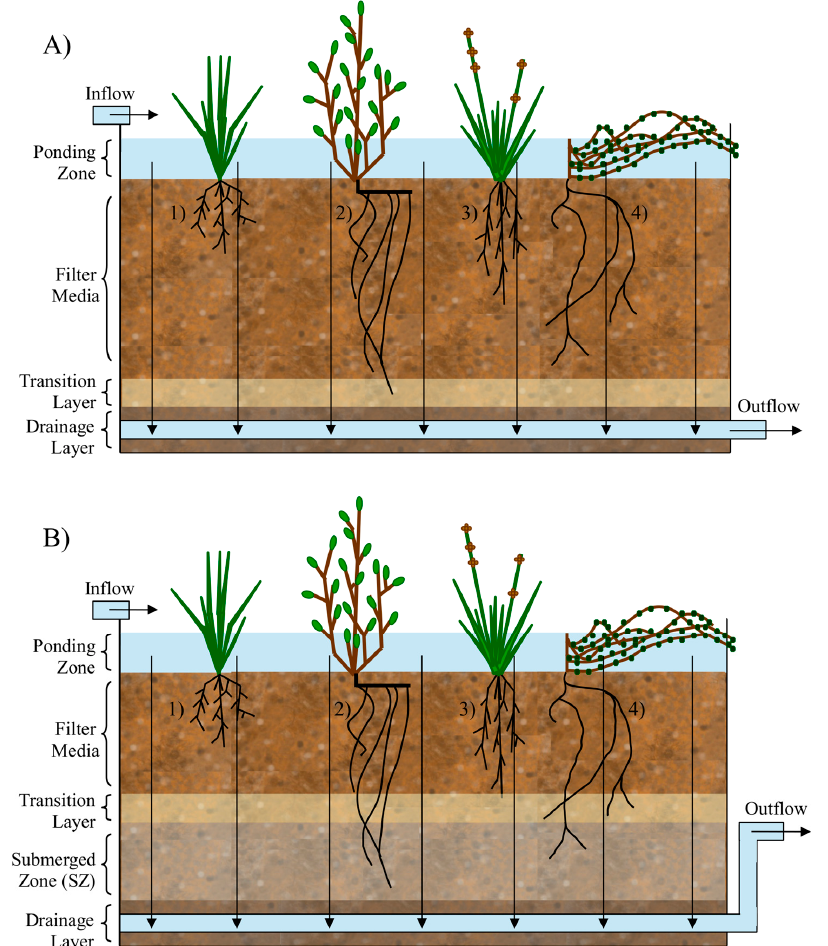
Figure 1. Schematics of a typical stormwater biofilter with ( B ) and without ( A ) a submerged zone (SZ). Both biofilters are planted with a variety of plant types reflecting different common above and below ground morphologies. These include herbaceous monocots with branching roots and shallow (1) vs. moderate (3) rooted depths, as well as upright (2) and creeping (4) dicots with deep rooted depths, low root branching, and high vs. low specific root density.